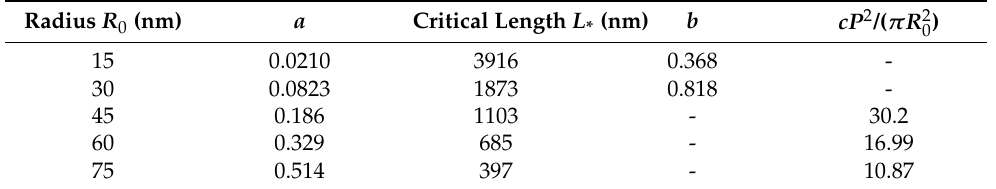
Table 2. Parameters of radius-dependent NW growth